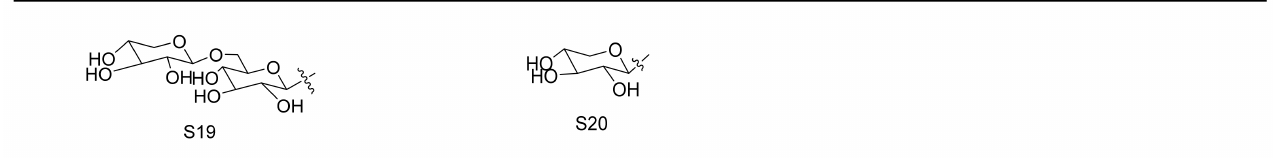
Figure 2. Structures of new dammarane-type saponins.